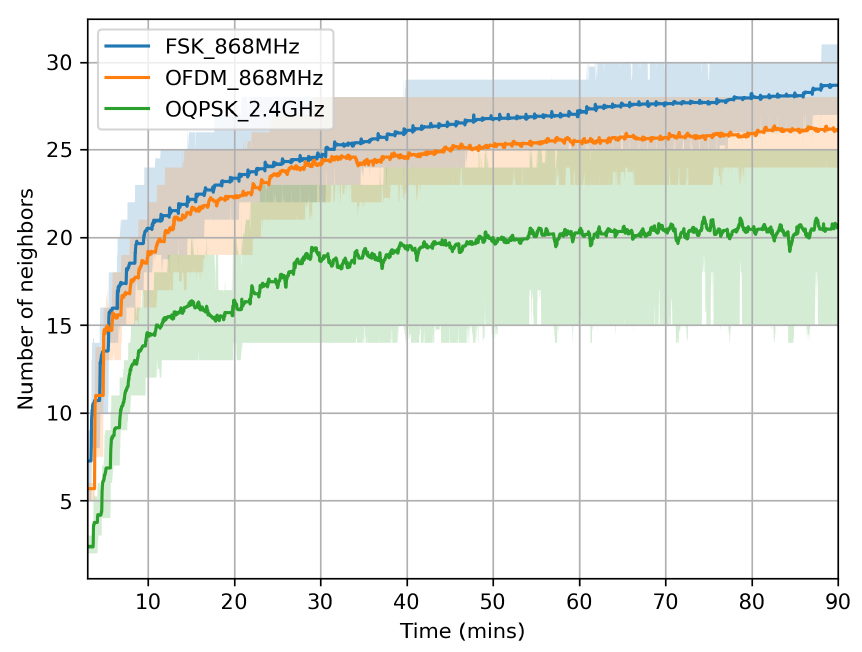
Figure 5. Motes discover more neighbors faster when using a longer-range